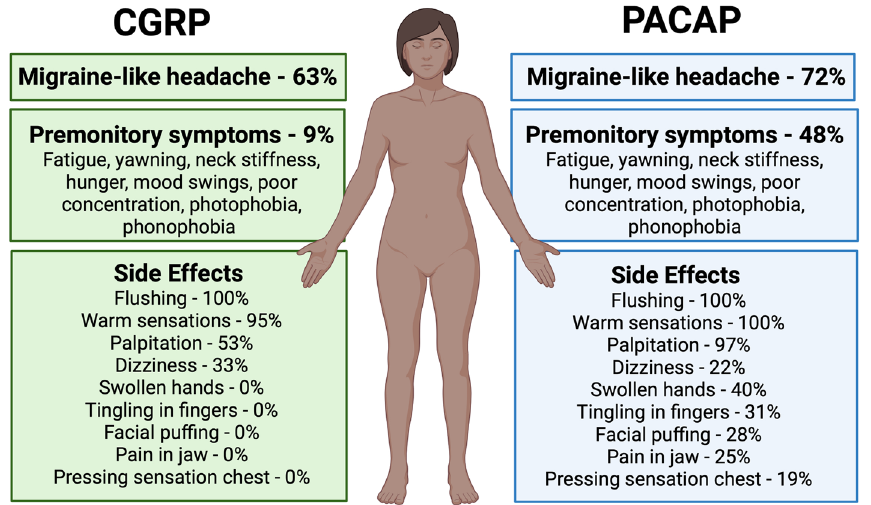
Fig. 1 Clinical symptoms caused by CGRP and PACAP infusions. Both CGRP and PACAP cause migraine-like headache in about 2/3 of migraine patients. PACAP causes more premonitory symptoms and side effects than CGRP. Data are only from studies that included premonitory